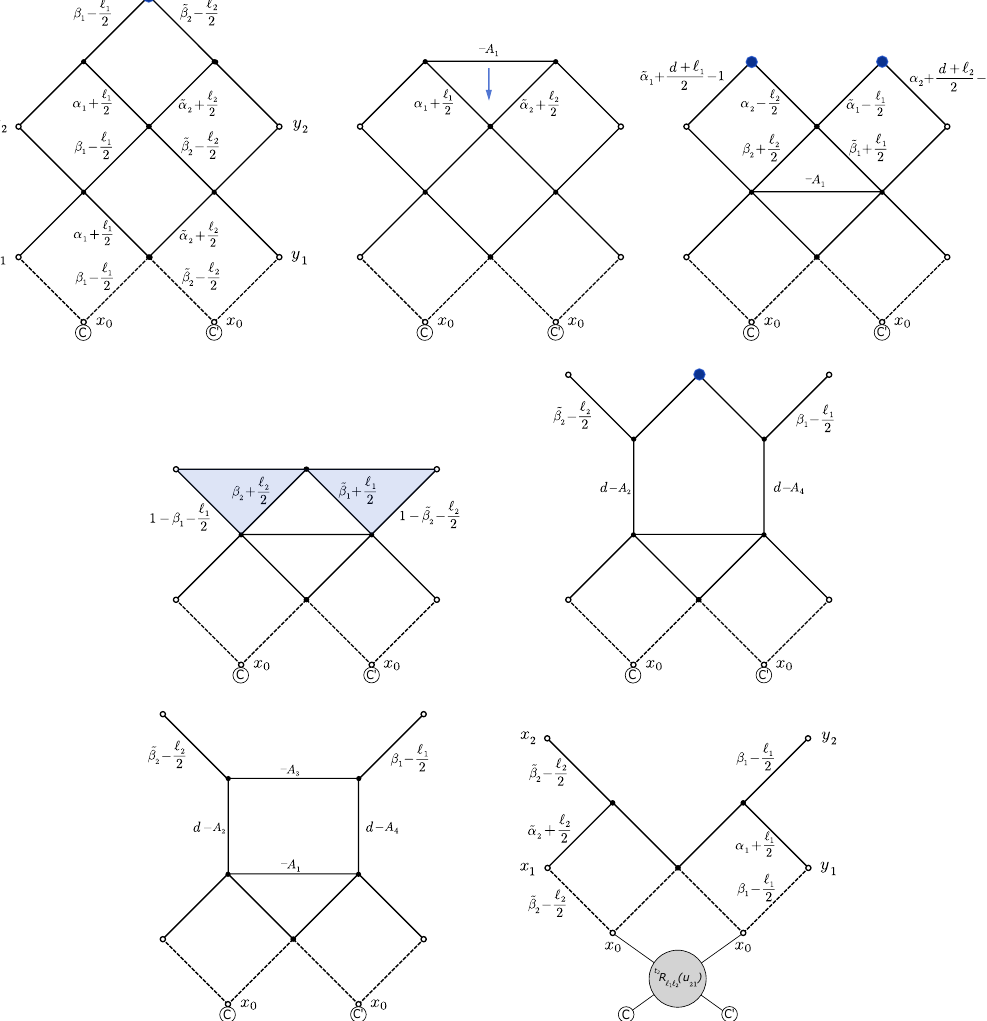
Figure 16 . Proof of the inner product formula. Up left to down right: the overlap of two layer operators C 0 · Λ 3 ( u 2 ) and C · Λ 3 ( u 1 ) is transformed via application of star-triangle identities and, at the last step, the interchange relation. The notation of blue dots, blue triangles and arrows is the same as in figure 11 and refers to different application of the star-triangle and chain-rule identities. The final expression coincides with the r.h.s. of (3.25). It shows that the overlap of two layers amounts to the scattering of the two excitations u 1 and u 2 across each other, this is expressed by the fused R-matrix R l ( u 12 ) 1 ,l 2